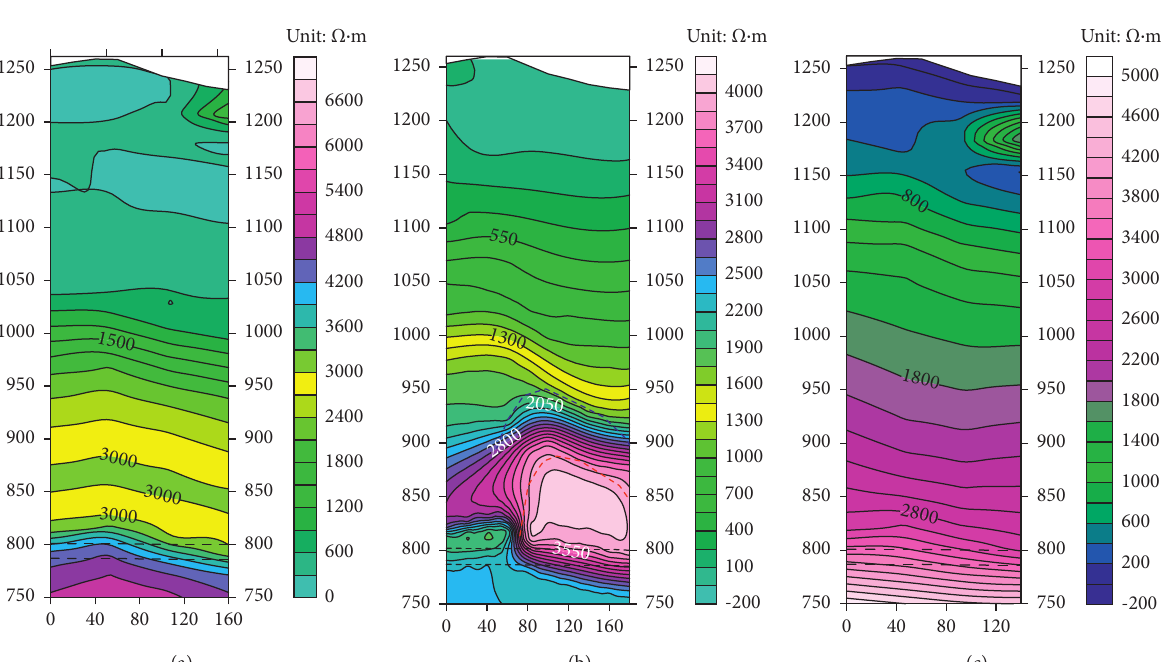
Figure 3: EH-4 two-dimensional inversion profiles of survey line #1. (a) The first stage (May 2011). (b) The second stage (August 2011). (c) The third stage (May